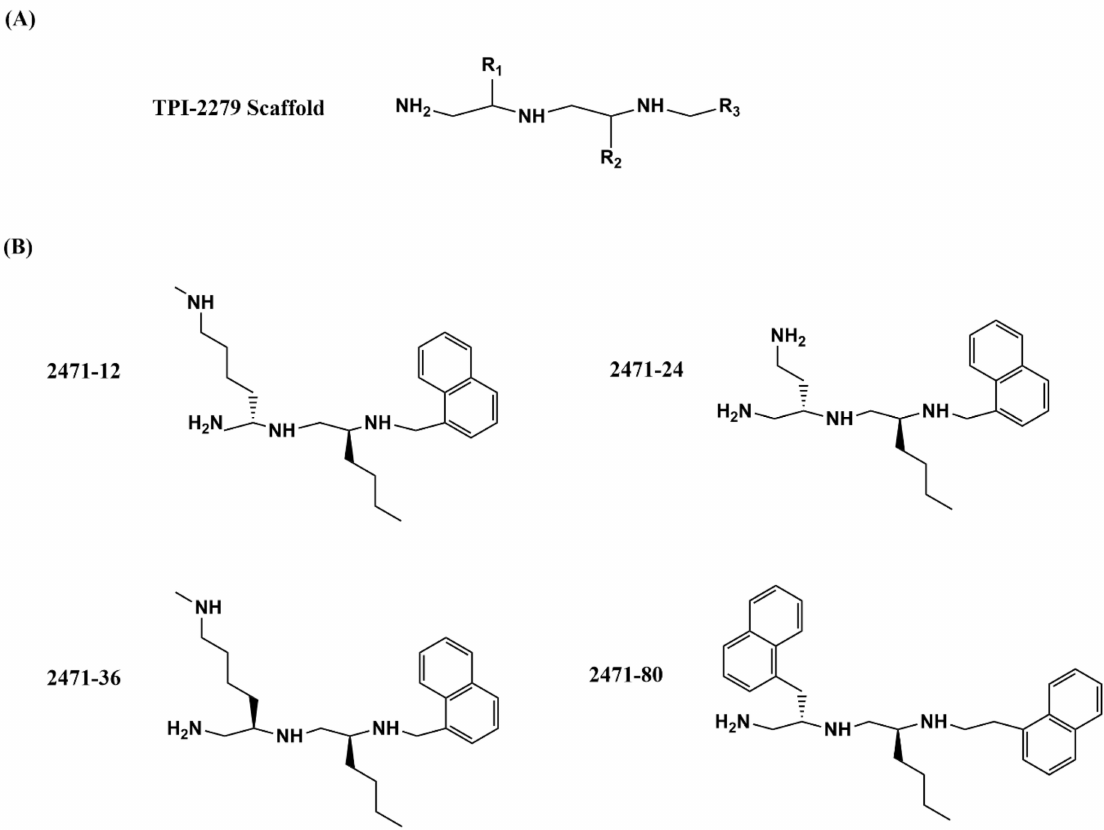
Figure 4. ( A ) Polyamine scaffold and ( B ) individual polyamine inhibitors of bacterial topoisomerase I with antimycobacterial activity